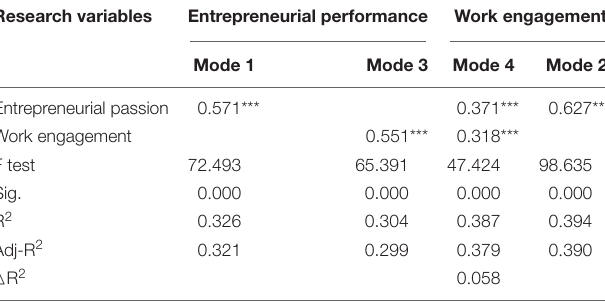
TABLE 6 | Mediating effects of work